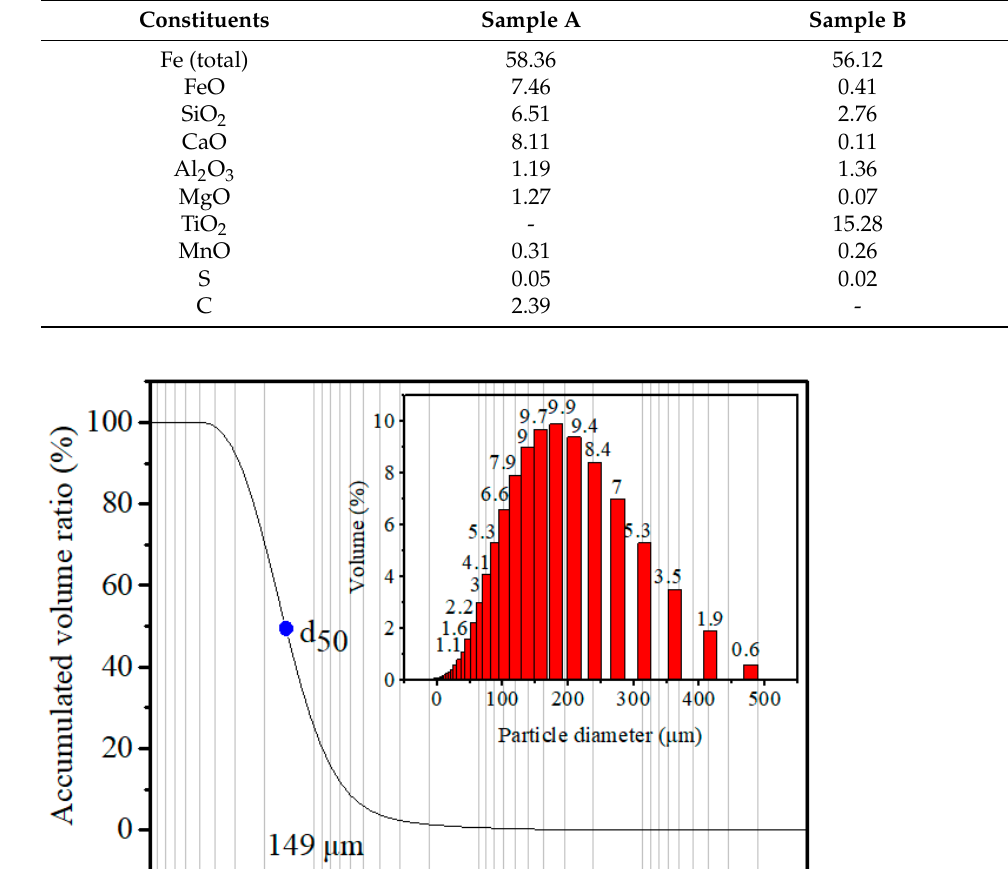
Figure 1. X ‐ ray diffraction patterns for ( a ) sample A, ( b ) sample B. Figure 1. X-ray diffraction patterns for ( a ) sample A, ( b ) sample B. Table 2. Chemical composition of iron ore raw material (wt.%). Table 2. Chemical composition of iron ore raw material (wt.%).